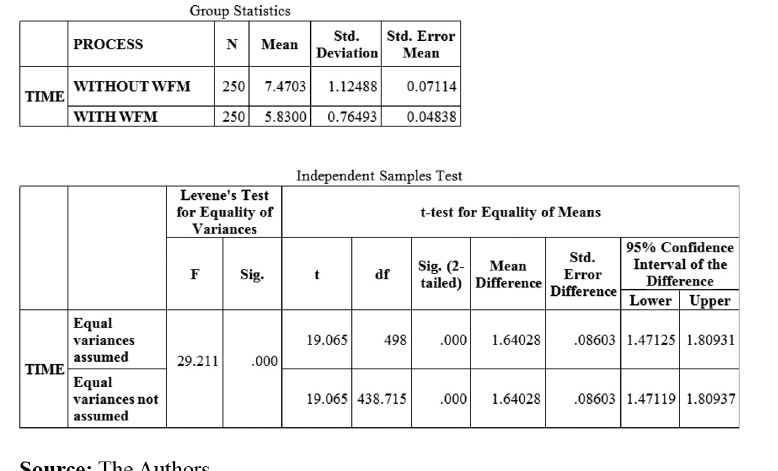
Figure 3. Result of the statistical analysis of the